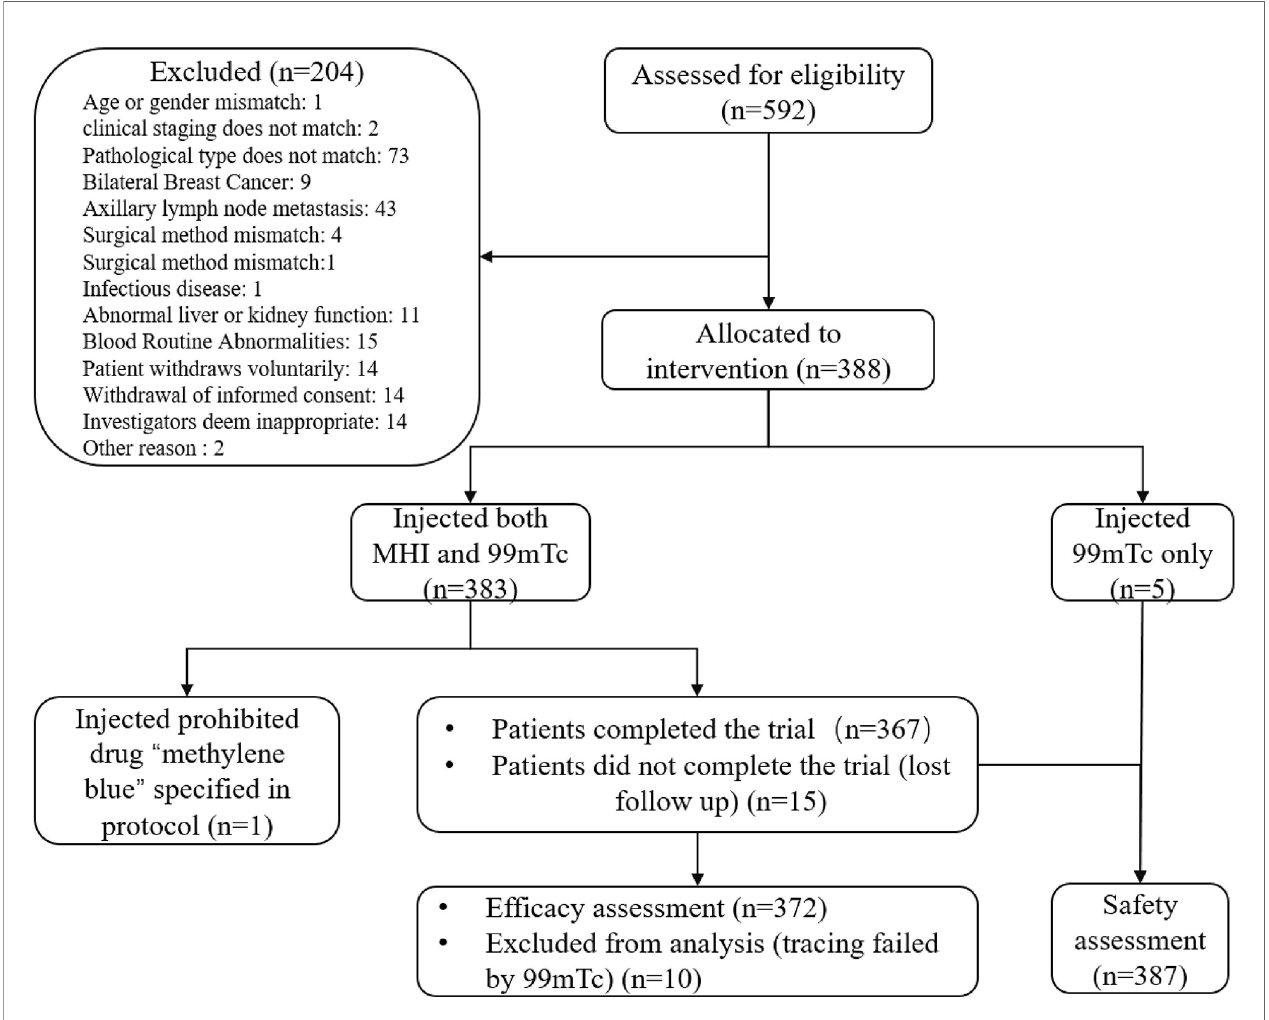
FIGURE 1 | Patient disposition. A total of 592 patients were screened; 204 failed screening, and 388 were ultimately enrolled. Of the enrolled patients, 383 were injected with both MHI and 99mTc. One patient was not included in the FAS or SS due to the use of the prohibited drug “ methylene blue ” as speci fi ed in the protocol. At the discretion of the Data Review Meeting, 382 patients were included in the FAS, and 387 patients were included in the